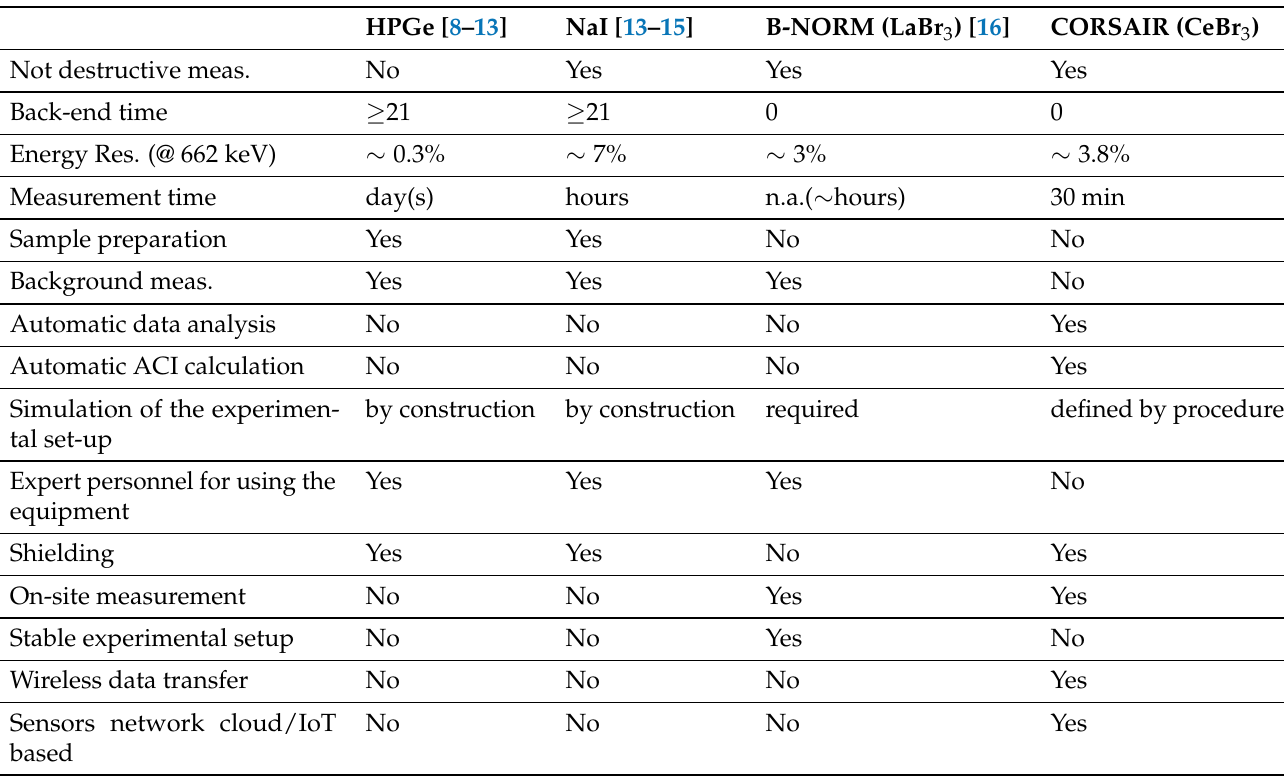
Table 1. Essential review of the main features of gamma spectrometers dedicated to radiological characterization of building